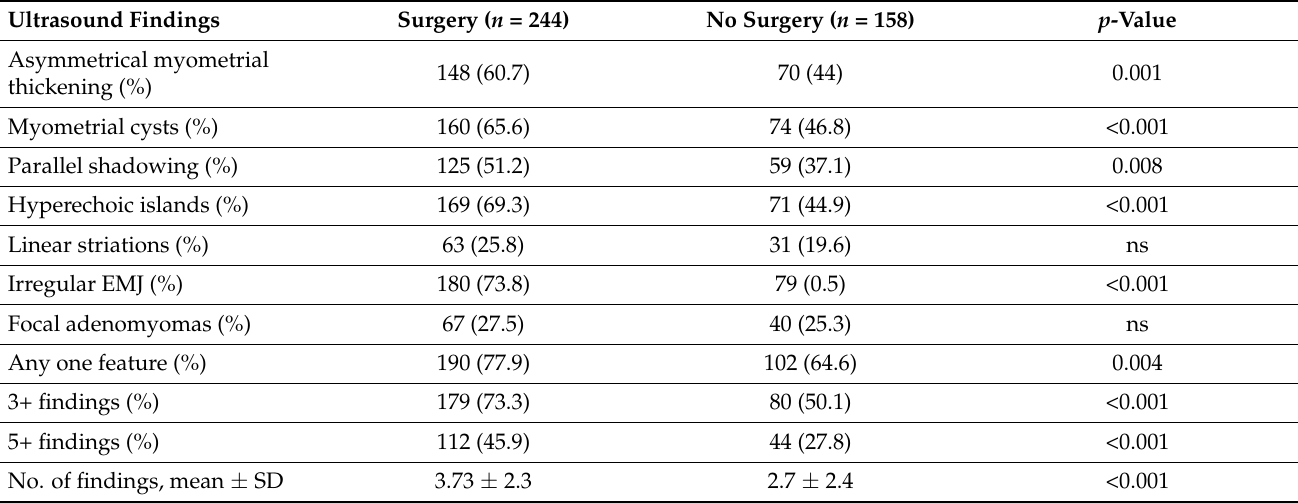
Table 2. TVUS findings suggestive of adenomyosis in women undergoing surgery for endometriosis versus no surgery.